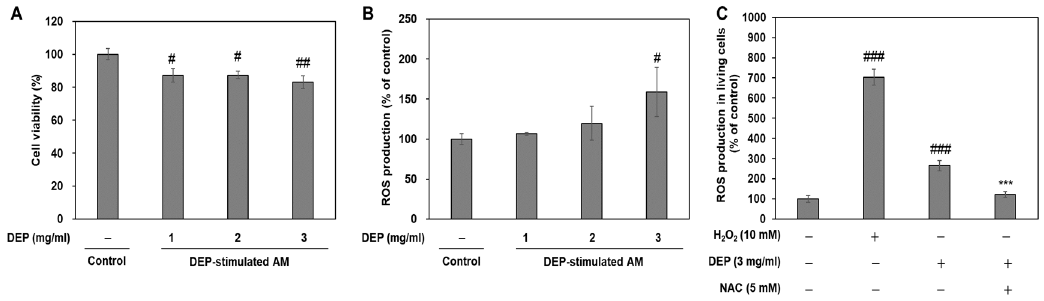
Figure 8. DEP induces oxidative stress-mediated cytotoxicity in DEP-treated AM. ( A ) Cytotoxicity assessment by MTT assay. ( B ) ROS production was measured by DCF-DA staining. AM were subjected to DEP (1, 2, or 3 mg mL − 1 ). DCF-DA staining and the MTT assay were performed 3 h after DEP challenge. ( C ) NAC pretreatment inhibits oxidative stress in DEP-stimulated AM. ROS production was measured in living cells by DCF-DA staining using flow cytometry. AM were pretreated with H2O2 for 30 min and NAC for 2 h and were stimulated with DEP (3 mg mL − 1 ) for 3 h. Data are means ± SD ( n = 3 per group). # p < 0.05, ## p < 0.01, ### p < 0.001 or vs. control; *** p < 0.001 or vs. DEP group.